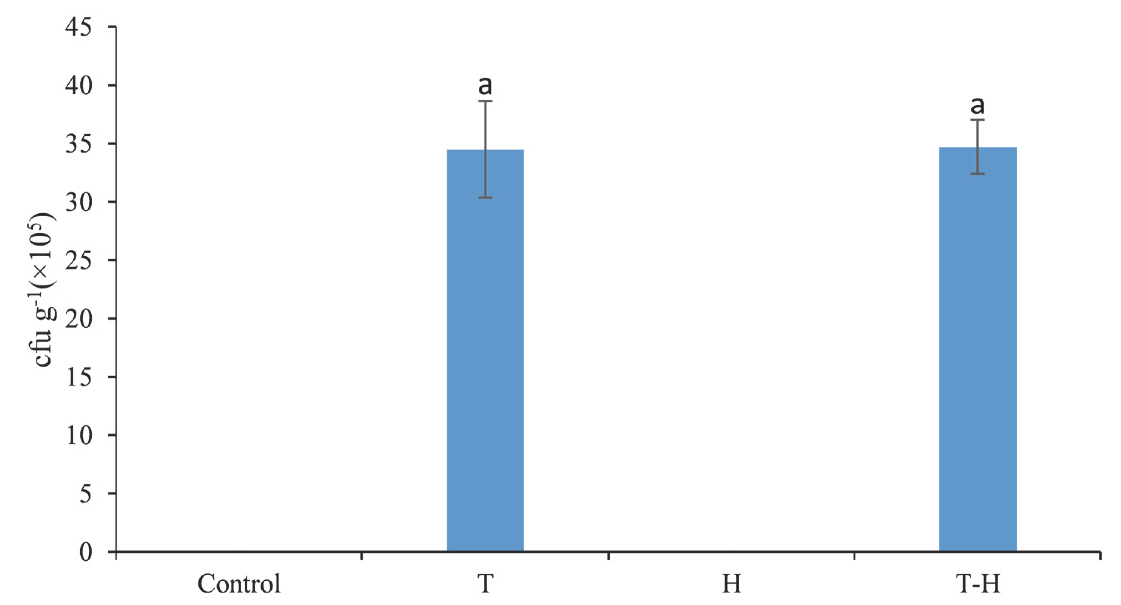
Figure 5. Colonization of T. asperellum SC012 strain in rhizosphere soil of cowpea. “Control”, “T”, “H” and “T-H” stand for “negative control”, “ Trichoderma treatment”, “hymexazol treatment” and “combination treatment”, respectively. Data presented are the means ± SE ( n = 3). Different letters indicate significant difference ( p < 0.05) among the treatments.